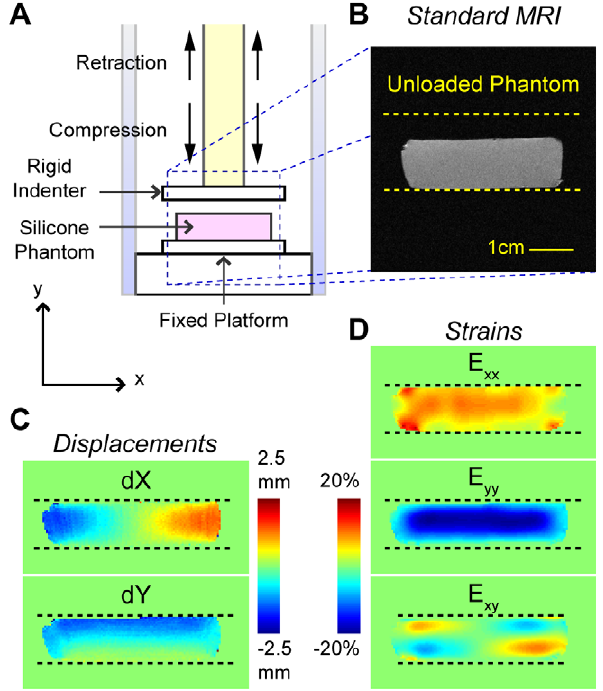
Figure 2. Displacements and strains determined by noninva- sive DENSE-FISP. An MRI-compatible loading apparatus cyclically loads a silicone gel phantom within a 9.4T MRI system by compressing the phantom against a fixed platform and then retracting after the load plateau ( A ). The unloaded phantom was imaged using standard MRI ( B ) prior to displacement-encoded MRI. In the representative images, displacements ( C ) and strains computed from smoothed displacements, after 25 smoothing cycles, ( D ) were found to be heterogeneous.